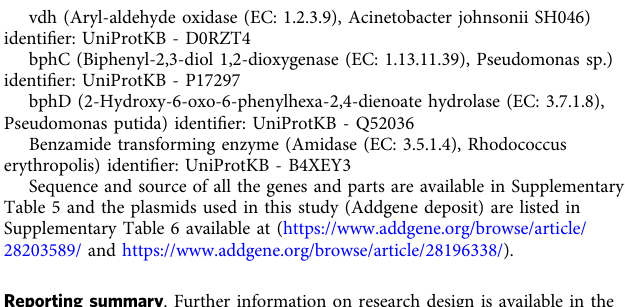
Supplementary Table 6 available at (https://www.addgene.org/browse/article/ 28203589/ and https://www.addgene.org/browse/article/28196338/). Reporting summary . Further information on research design is available in the Nature Research Reporting Summary linked to this